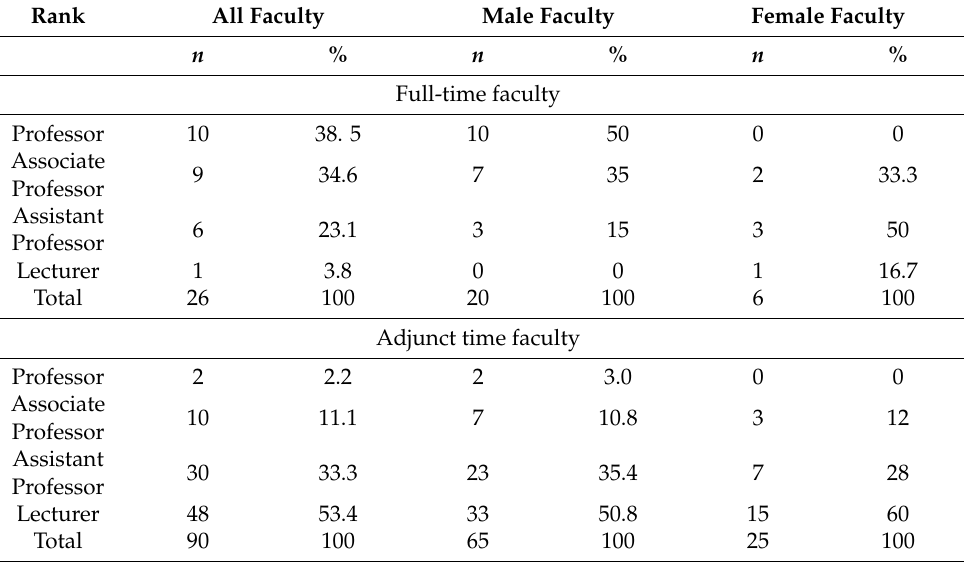
Table 4. Academic rank distribution by gender for all full-time family medicine physician faculty members in Taiwan medical schools in